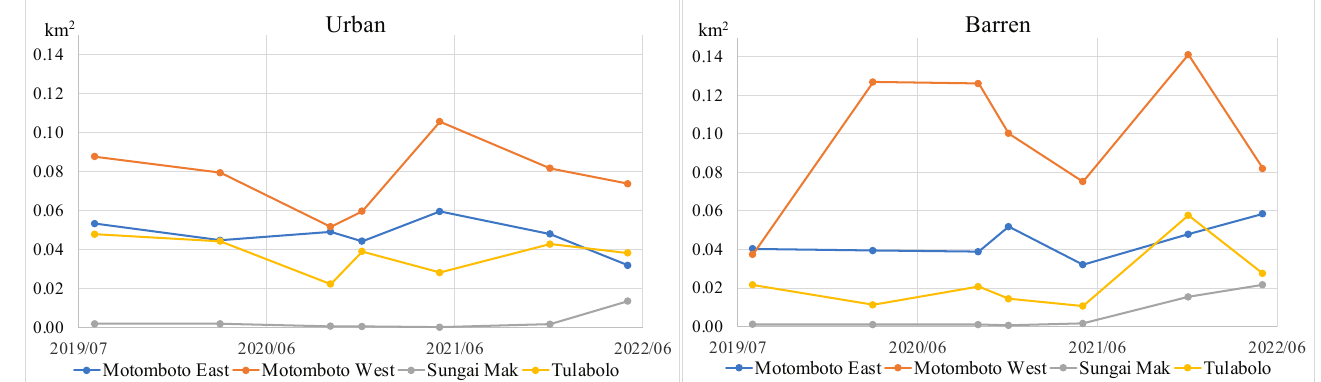
Figure 6. Time series of landcover changes of built-up and barren extents by target deposits. Table 3. Entire river extents, eroded extents, and eroded volumes from 2002 to 2022 in the study area. River Extents (km 2 ) Eroded Extents (km 2